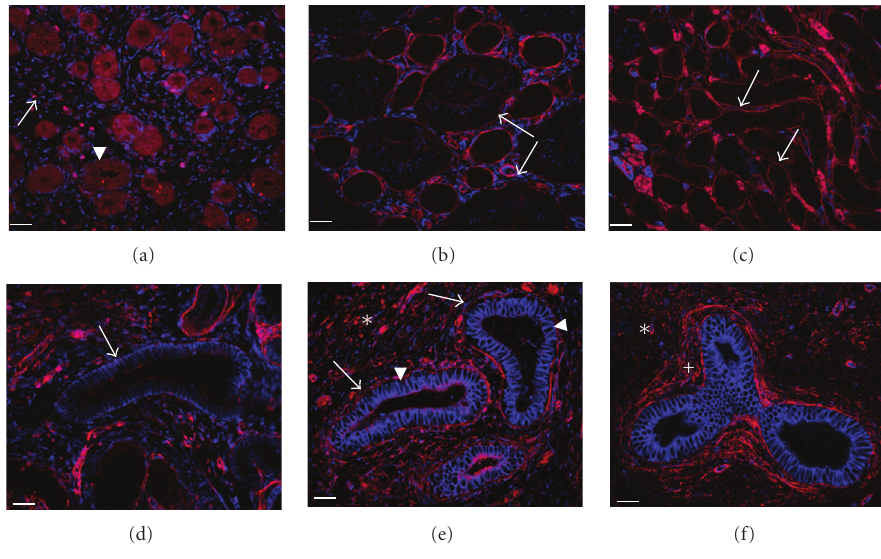
Figure 5: Vimentin and collagen IV immunoreactivity . Normal kidneys ((a)–(c)). (a) Interstitial expression of vimentin-IR (blue) (arrow) and di ff use cytoplasmic expression of collagen IV (ColIV)-IR (red) (arrowhead) are present in the mid gestation (18 weeks) kidney. (b) Thin, regular, well-defined expression of ColIV-IR in the CD basement membranes (arrows) is well established by late gestation (27 weeks), and (c) persists postnatally (12 months) (arrows). Obstructed kidneys ((d)–(f)). (d) De novo basolateral expression of vimentin-IR (blue) (arrow) in the CD epithelium of the obstructed 18 weeks gestation kidney. (e) More pronounced vimentin-IR expression (arrowheads) and disruption of ColIV-IR expression (red) (arrows) in the CD basement membrane of the late gestation (36 weeks) obstructed CD epithelium, and (f) in the obstructed postnatal (16 months) kidneys. Deposition of ColIV-IR in the expanded interstitium (asterisk), and in the periductal collars (plus) is also present. Scale bar = 25 μ